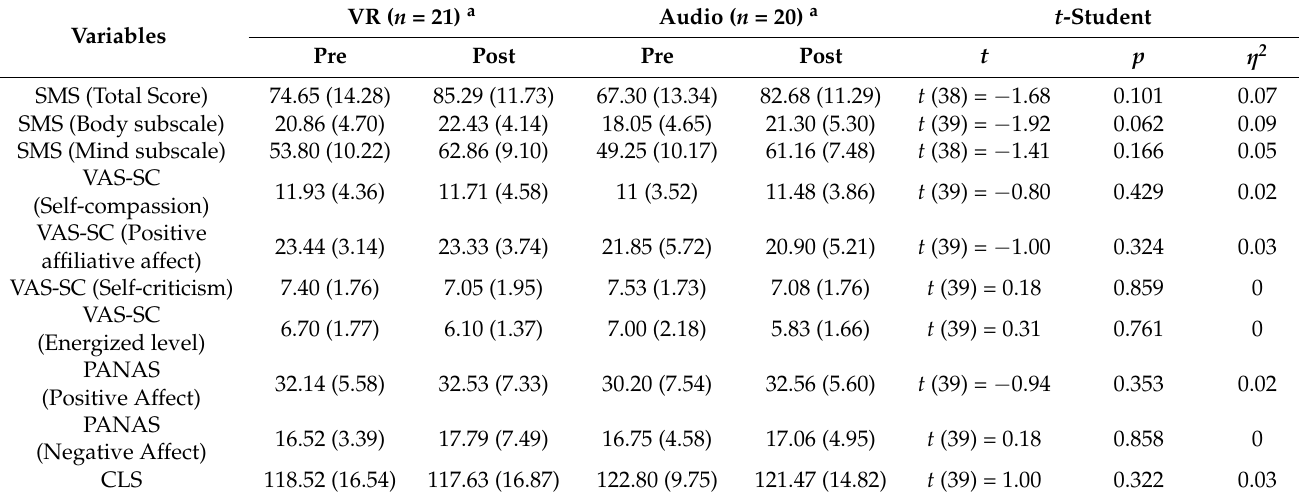
Table 2. Descriptive statistics and independent-samples t -test results of baseline